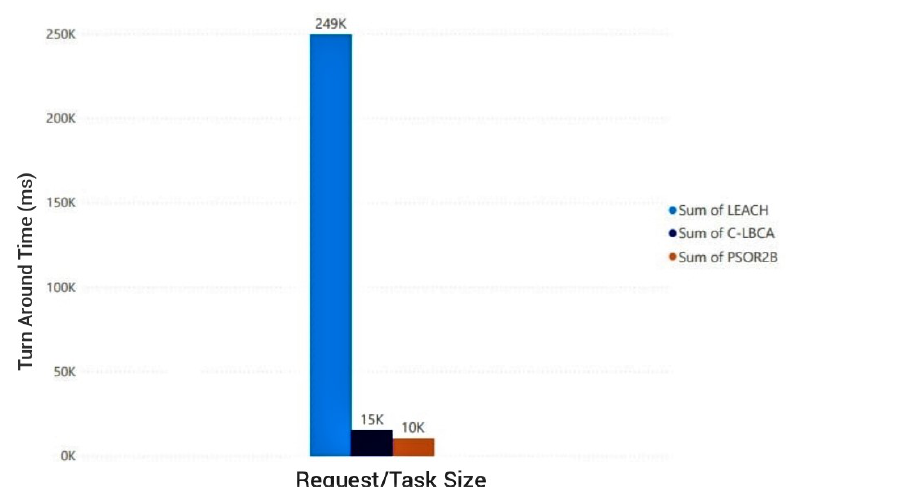
Figure 13. Cumulative turnaround time of LEACH vs C-LBCA vs PSOR2B.